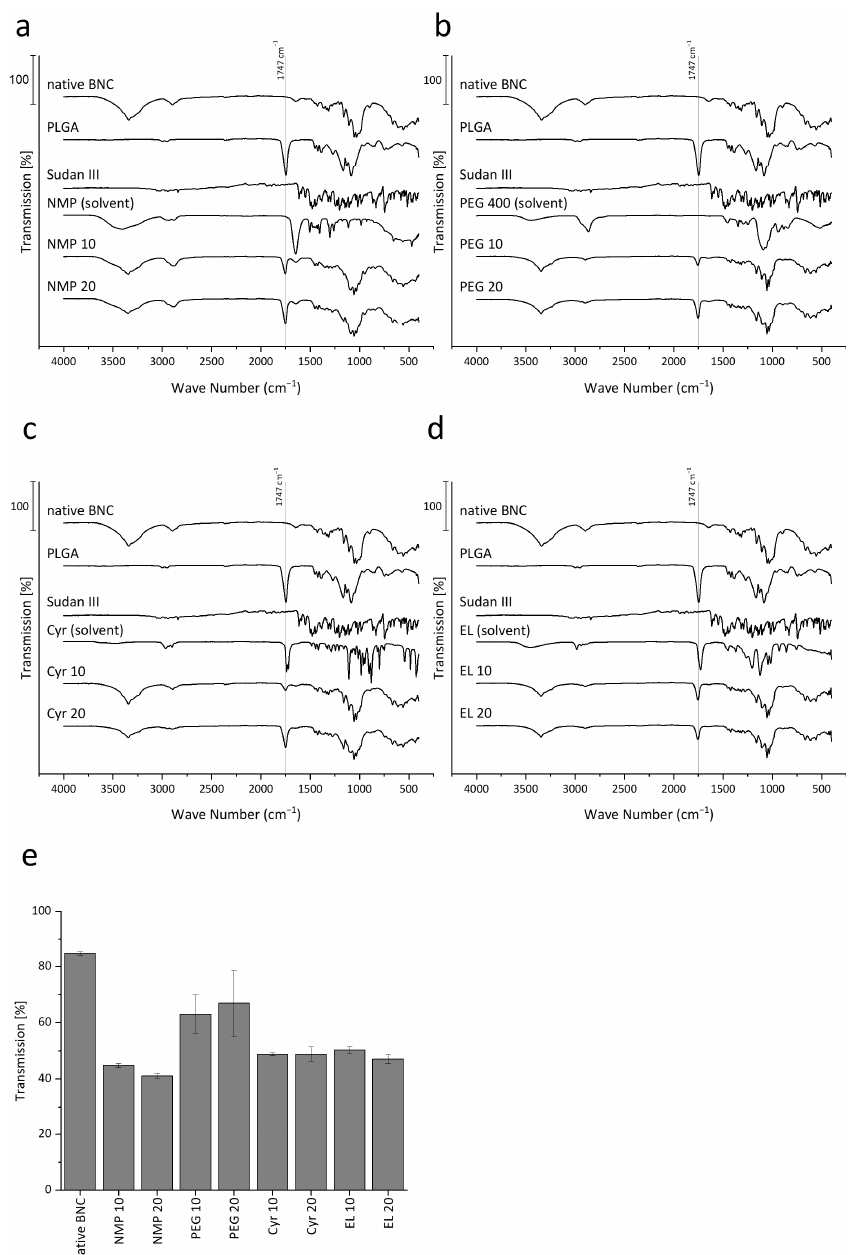
Figure 2. ( a – d ) ATR-FT-IR spectra of PLGA loaded fleeces in comparison to native BNC, Sudan III, pure PLGA, and the used solvents. Spectra are combined for the respective formulation approaches based on NMP ( a ), PEG 400 ( b ), Cyr ( c ), and EL ( d ). The marked bands at 1747 cm − 1 are related to the stretching of the carbonyl functionality of PLGA. ( e ) Concentration and solvent-dependent light transmission through native BNC in comparison to PLGA loaded fleeces expressed as percentage transmission at 600 nm from five equally distributed points per fleece using UV/vis spectrophotometry (mean ± SD of six different fleeces from two independent experiments).